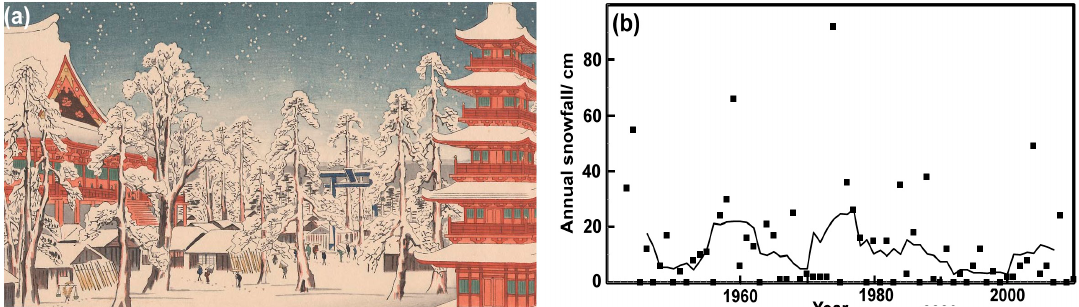
Figure 10. ( a ) Hiroshige’s Snow Scene at Kinryuzan Buddist Temple, Asakusa District ( b ) Annual Tokyo snowfall. The line shows the 7-year running mean. Note: Image is part of Toto Yukimi Hakkei (8 Snow Scenes of the Eastern Metropolis): http://mercury.lcs.mit.edu/~jnc/prints/8snow.html [68]. Data from WMO Station ID:47662 of JMA.